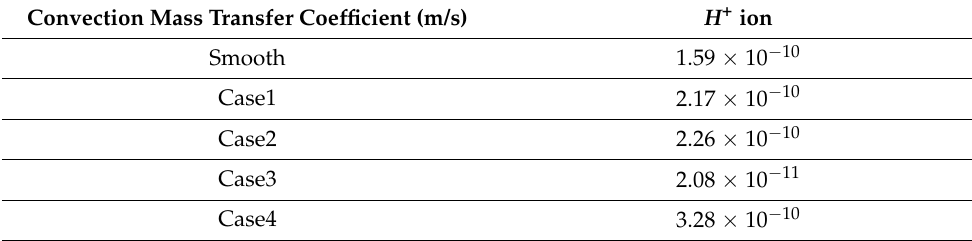
Table 2. Convection mass transfer coefficient.